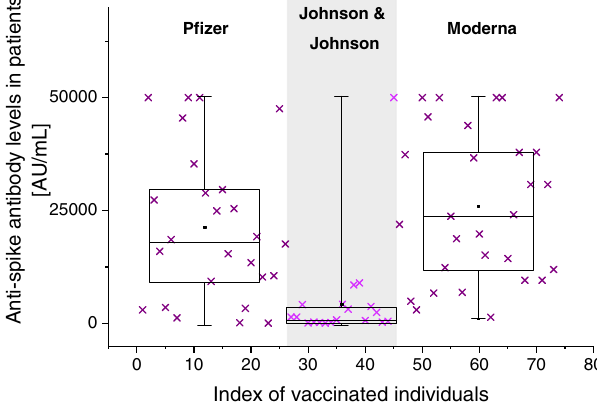
Fig. 3 Anti – SARS-CoV-2 antibody concentration levels. Anti-spike IgG antibody levels in patient samples were measured using Abbott ’ s SARS-CoV- 2 IgG II Quant ARCHITECT assay. Comparing these antibody concentrations, the one-dose J&J vaccine induces lower antibody levels than the two-dose P fi zer and Moderna vaccines. There is no signi fi cant difference in mean concentrations between individuals vaccinated with P fi zer vs Moderna (the Tukey HSD test p -value = 0.5108). However, there is a signi fi cant difference in antibody concentration levels across the three groups as determined by ANOVA (F-test p -value = 0.0001), and pairwise Tukey HSD (P fi zer vs J&J: p -value = 0.0019; Moderna vs J&J: p -value = 0.0000). The number of samples tested was 26, 19, and 29 for P fi zer, Johnson & Johnson, and Moderna, respectively.